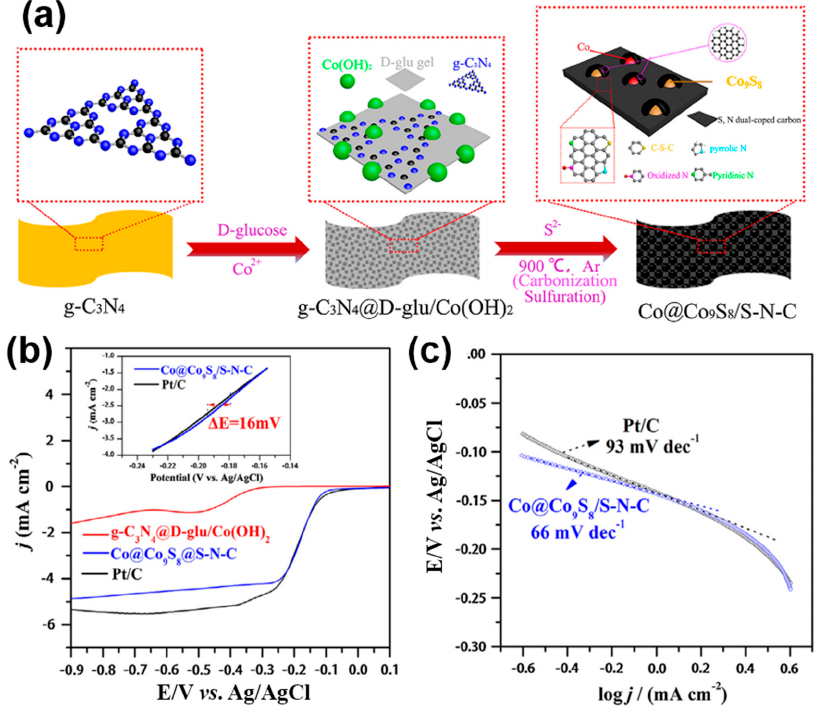
Figure 5. ( a ) The schematic chemical synthesis route of Co@Co 9 S 8 /S–N–C; ( b ) linear sweep voltammetry (LSV) curves for the g–C 3 N 4 @D–glu/Co(OH) 2 , Co@Co 9 S 8 /S–N–C, and Pt/C electrodes recorded in O 2 -saturated 0.1 KOH solution at 1600 rpm with scan rate of 10 mV s − 1 (cathodic sweep) at 25 °C (catalyst mass loading: 0.2 mg cm − 2 ); ( c ) Tafel plots of Co@Co 9 S 8 /S–N–C and Pt/C catalysts. Reproduced from [68], Copyright © Elsevier,